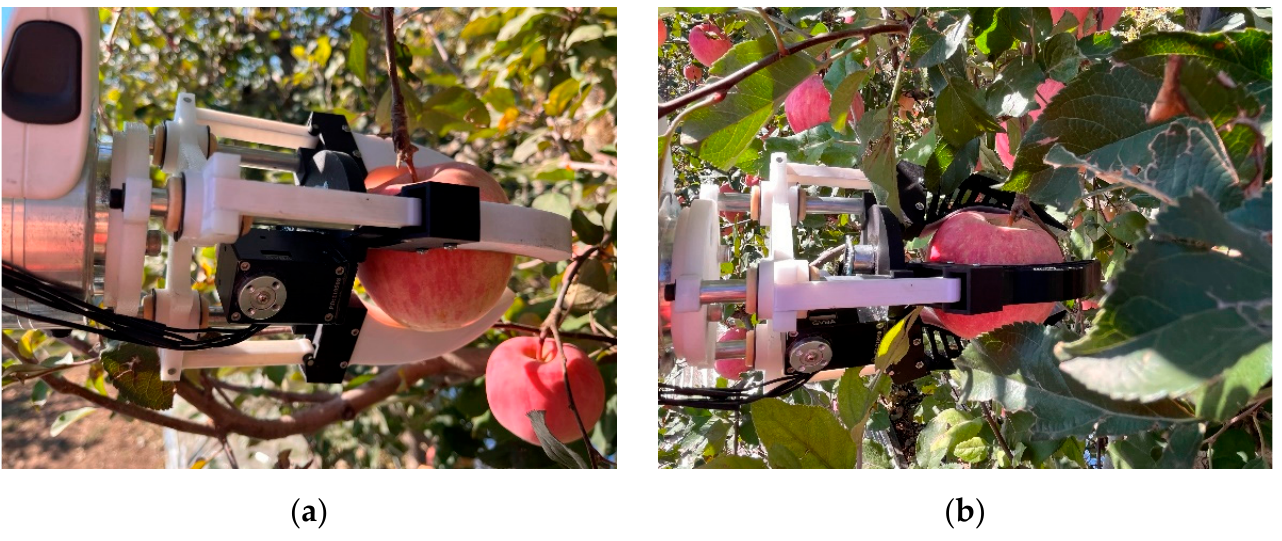
Figure 27. Three sets of outdoor picking experiments: ( a ) rigid fingers; ( b ) soft fingers with or without slip detection.